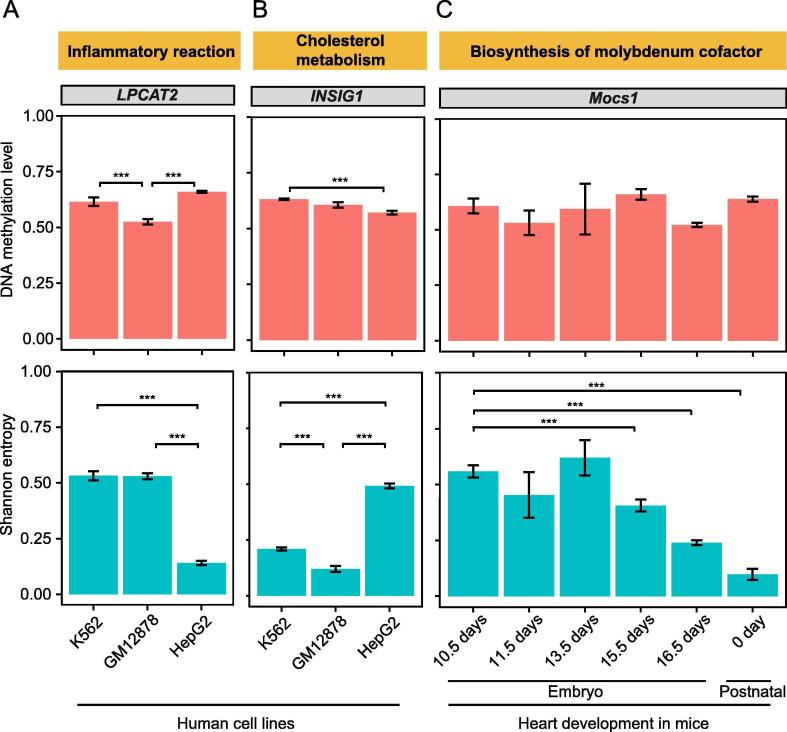
Examples of genes showing the difference in Shannon entropy between cell lines or developmental stagesA.LPCAT2, a gene related to inflammatory reactions, exhibits similar DNA methylation levels but different Shannon entropy values among three human cell lines including K562, GM12878, and HepG2. B.INSIG1, a gene related to cholesterol metabolism, exhibits similar DNA methylation levels but different Shannon entropy values among three human cell lines including K562, GM12878, and HepG2. C.Mocs1, a mouse gene related to the biosynthesis of molybdenum cofactor, exhibits different Shannon entropy values during the development of mouse heart. Data in embryos of 12.5 and 14.5 days were not shown due to the low quality. Error bars that represent the standard errors of the mean values were calculated with bootstrapping and P values were calculated from permutation test. ***indicates a significant difference in DNA methylation level or heterogeneity between different samples (P < 0.001). LPCAT2, lysophosphatidylcholine acyltransferase 2; INSIG1, insulin induced gene 1; Mocs1, molybdenum cofactor biosynthesis protein 1.